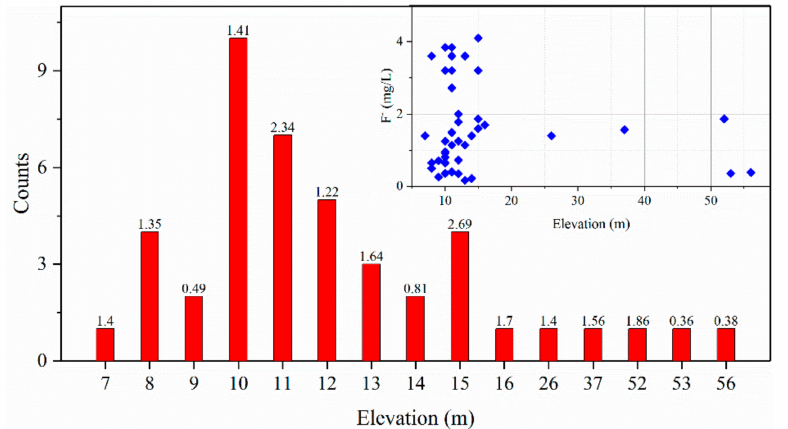
Figure 4. Influence of topography on fluoride in groundwater of the Jiaolai Basin, Jiaodong Peninsula, eastern China. The data label above the bar is the average F − concentration of all water samples at this